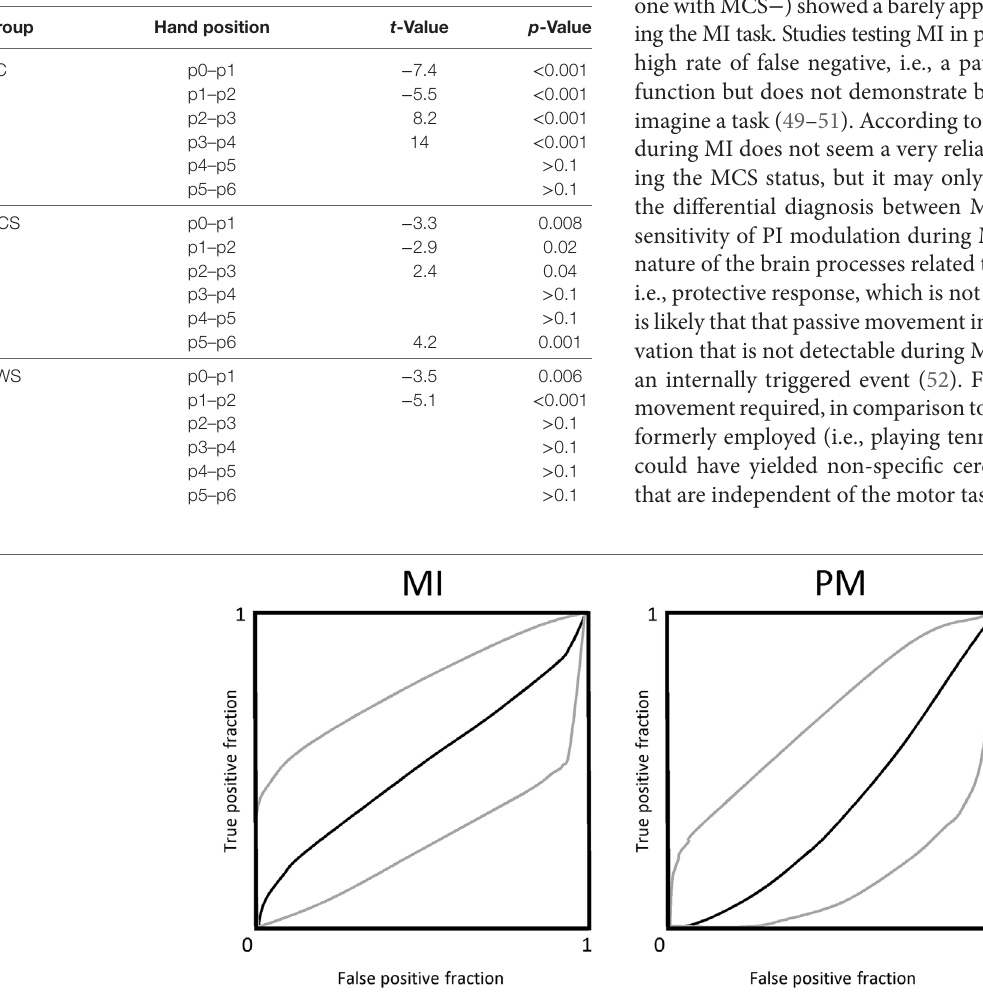
Table 3 | Post hoc t -test concerning heart rate (HR) modulation at each hand position (p) as compared to the previous one (significant when p -value < 0.0125), during the passive motor task in patients with minimally conscious state (MCS) and unresponsive wakefulness syndrome (UWS), and in healthy controls (HC). HR data of motor imagery were not